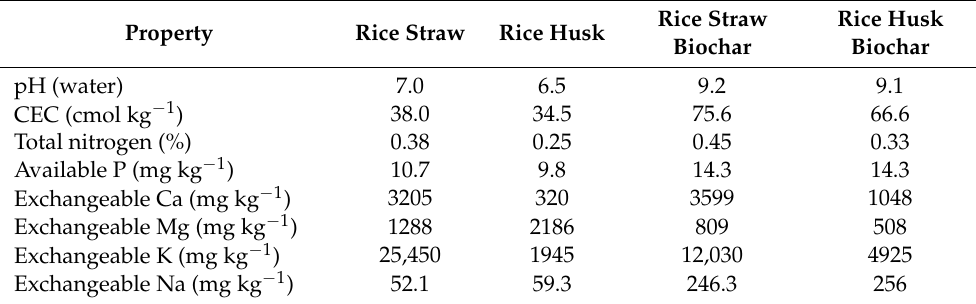
Rice Straw Rice Rice Straw Rice Husk Biochar